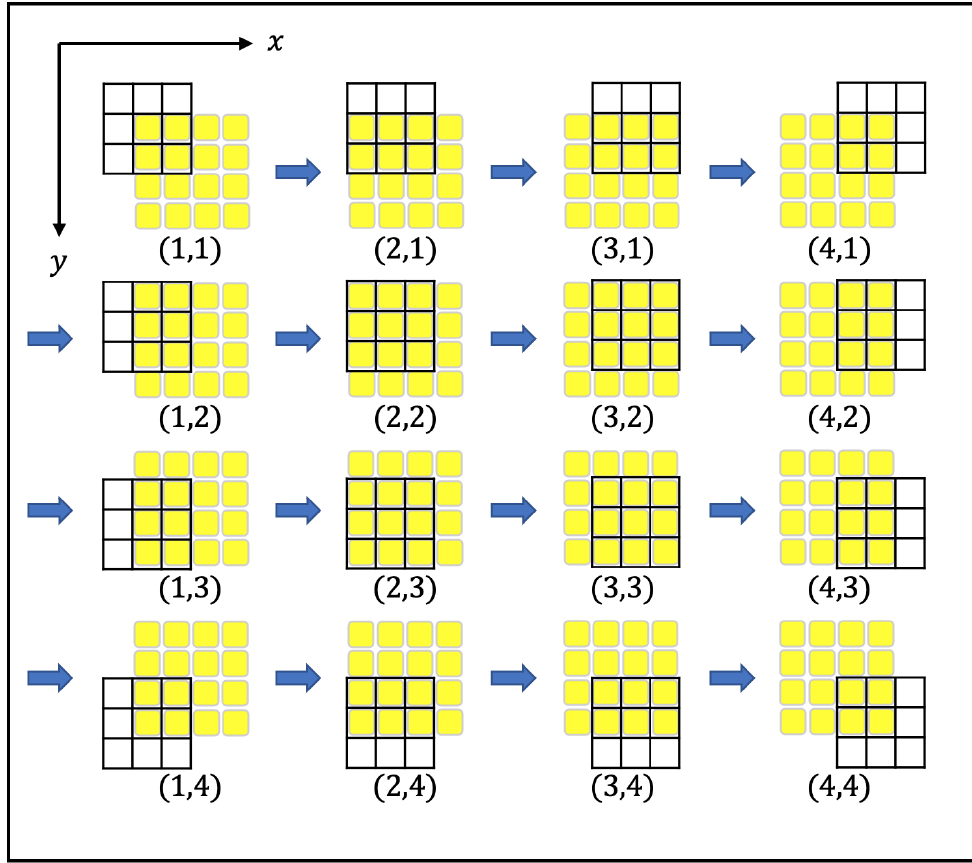
Figure 5. The scanning process of LMDNs. The center pixel of the local receptive field crosses each pixel of the global receptive field in turn. For the situations on scanning the edge pixels, padding of any constance affects few to AVS